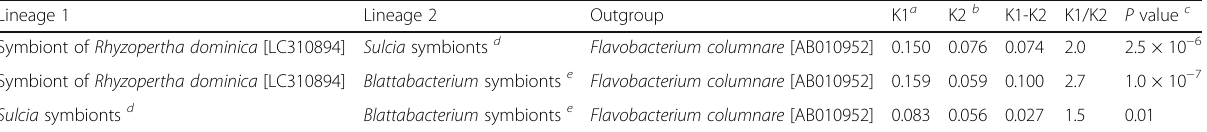
Table 1 Relative rate tests of 16S rRNA gene sequences of the symbiont of Rhyzopertha dominica in comparison with Sulcia